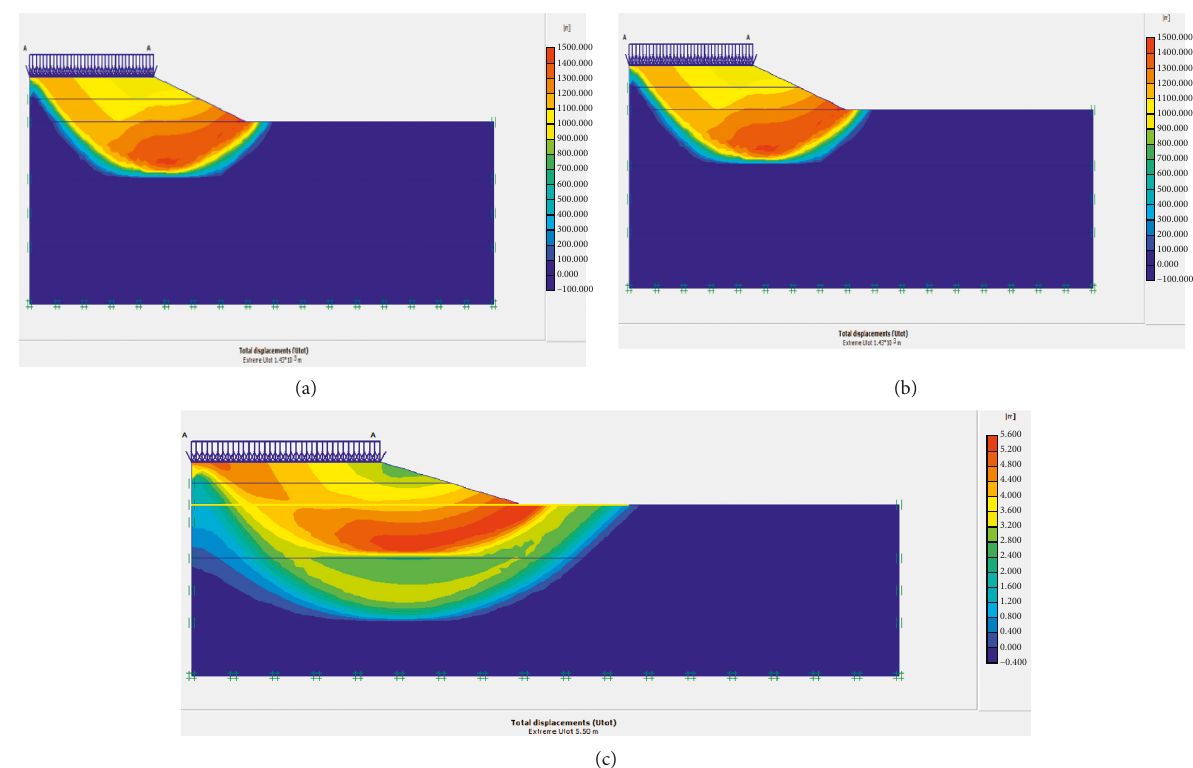
Figure 10: Total displacements of H2S3. (a) Natural soil (b) unreinforced stabilized soil. (c) Geogrid reinforced stabilized